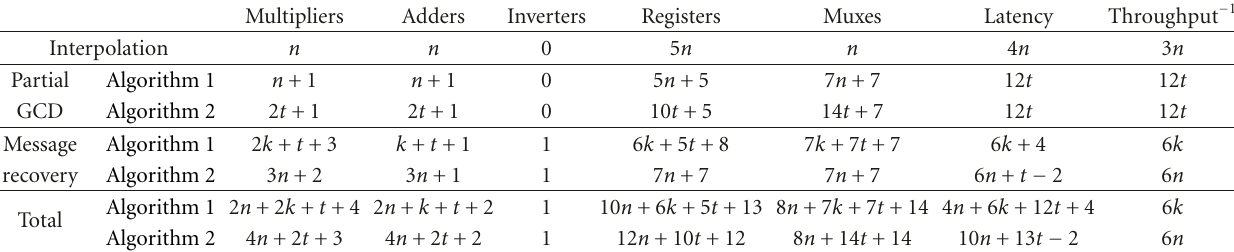
Table 4: Decoder architectures based on syndromeless decoding (CPD is T mult + T add + T mux )